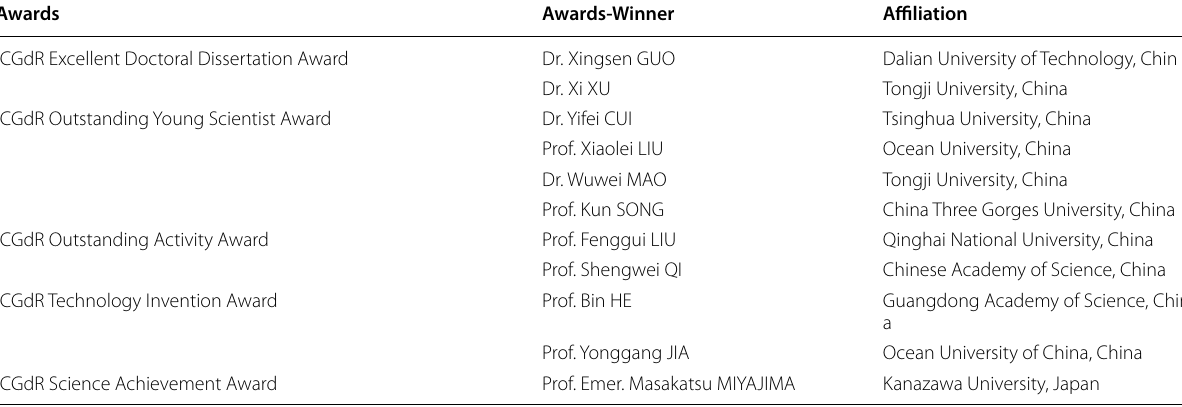
Table 1 Winners of five ICGdR awards Awards